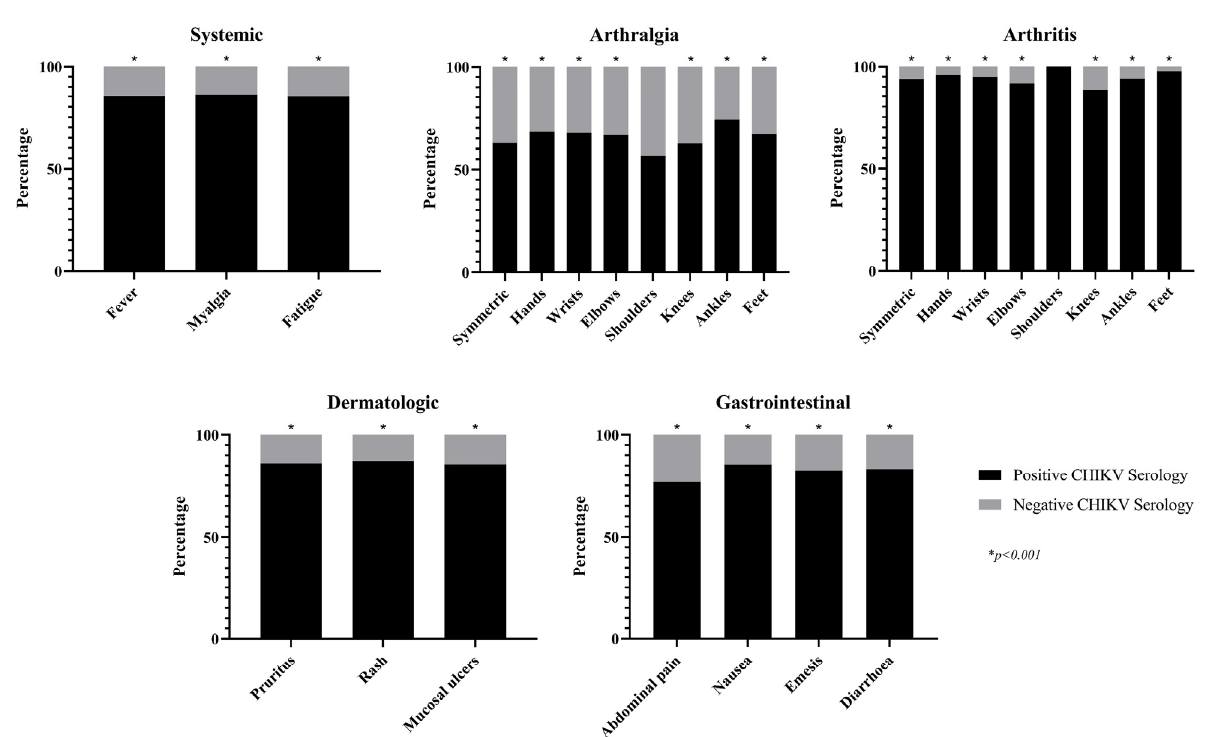
Figure 4. Clinical characteristics of the study population. CHIKV: Chikungunya virus.